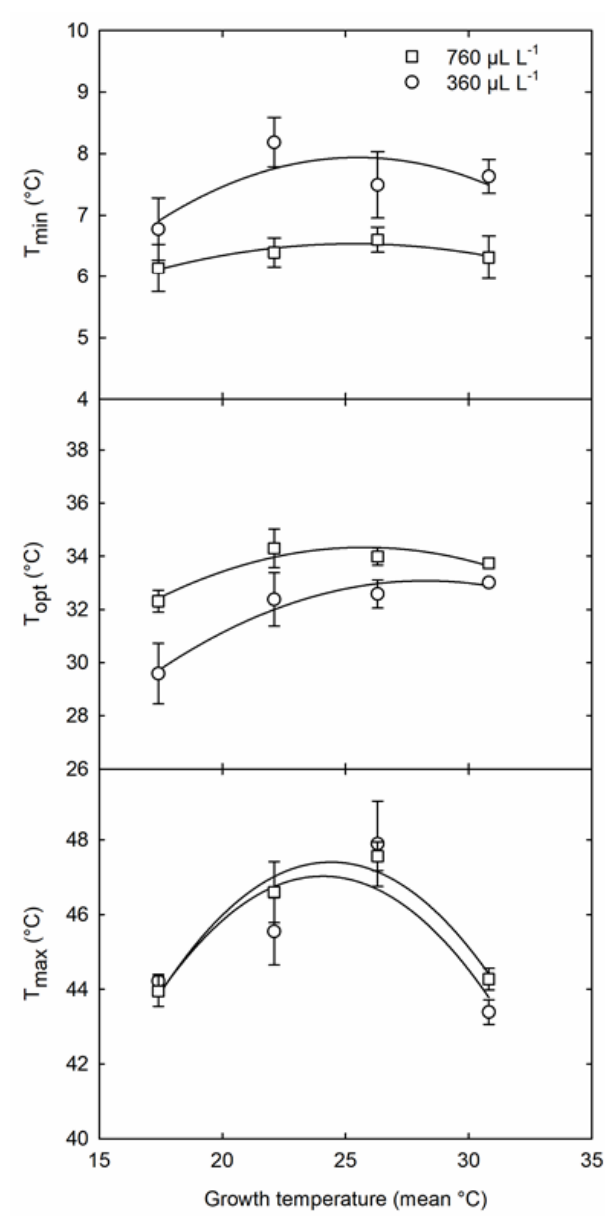
Figure 5. Influence of growth temperature and carbon dioxide during seed development on cardinal temperatures derived from cumulative seed germination percentages and time series across a range of temperatures for seed germination. Data are means ± SE of four plants ( n = 4) harvested from a given SPAR unit and used as replicates in statistical analysis for a respective parental environment.